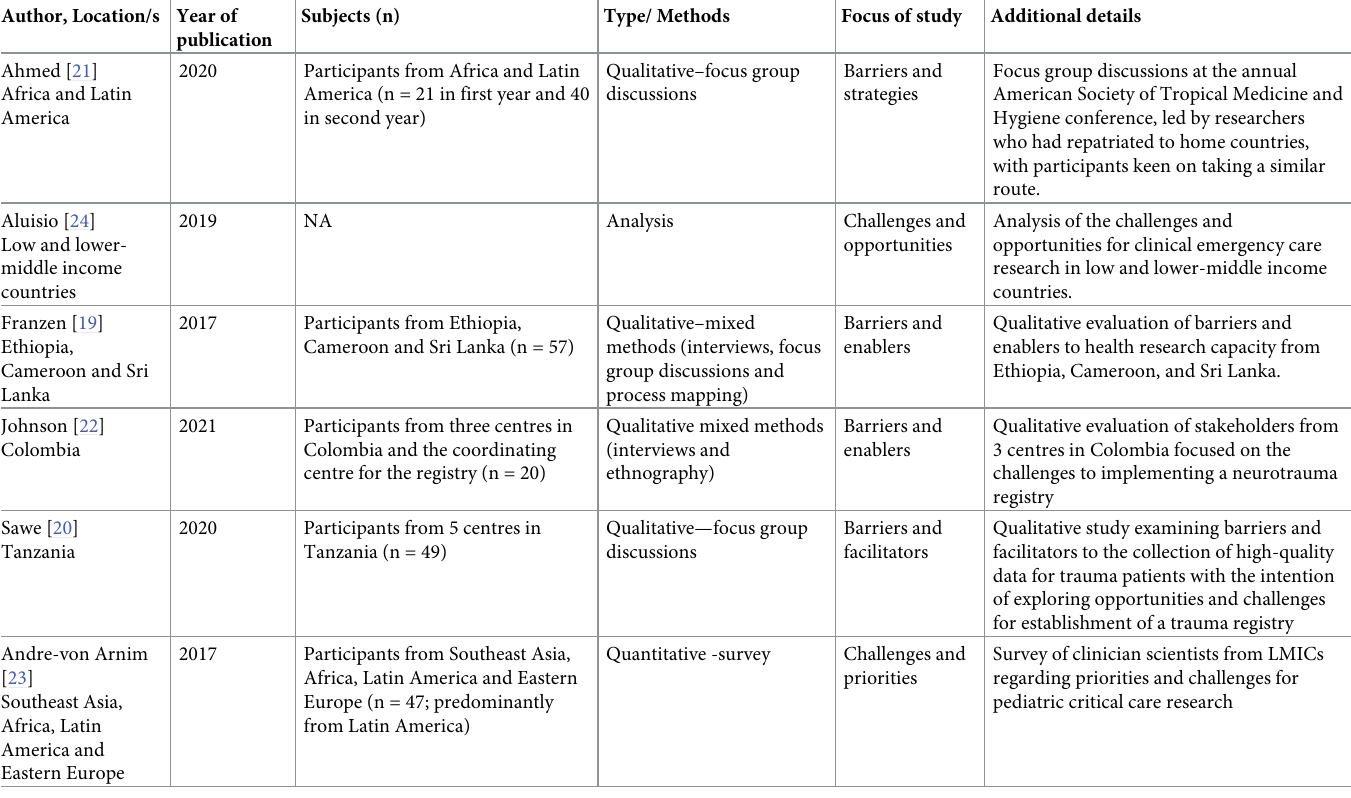
Table 1. Characteristics of the included